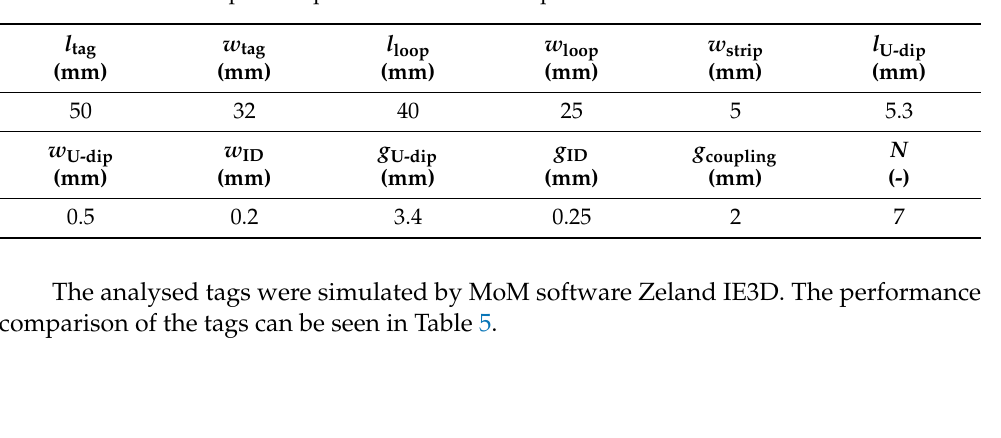
Table 4. Size of IC U-dipole coupled in the metallic